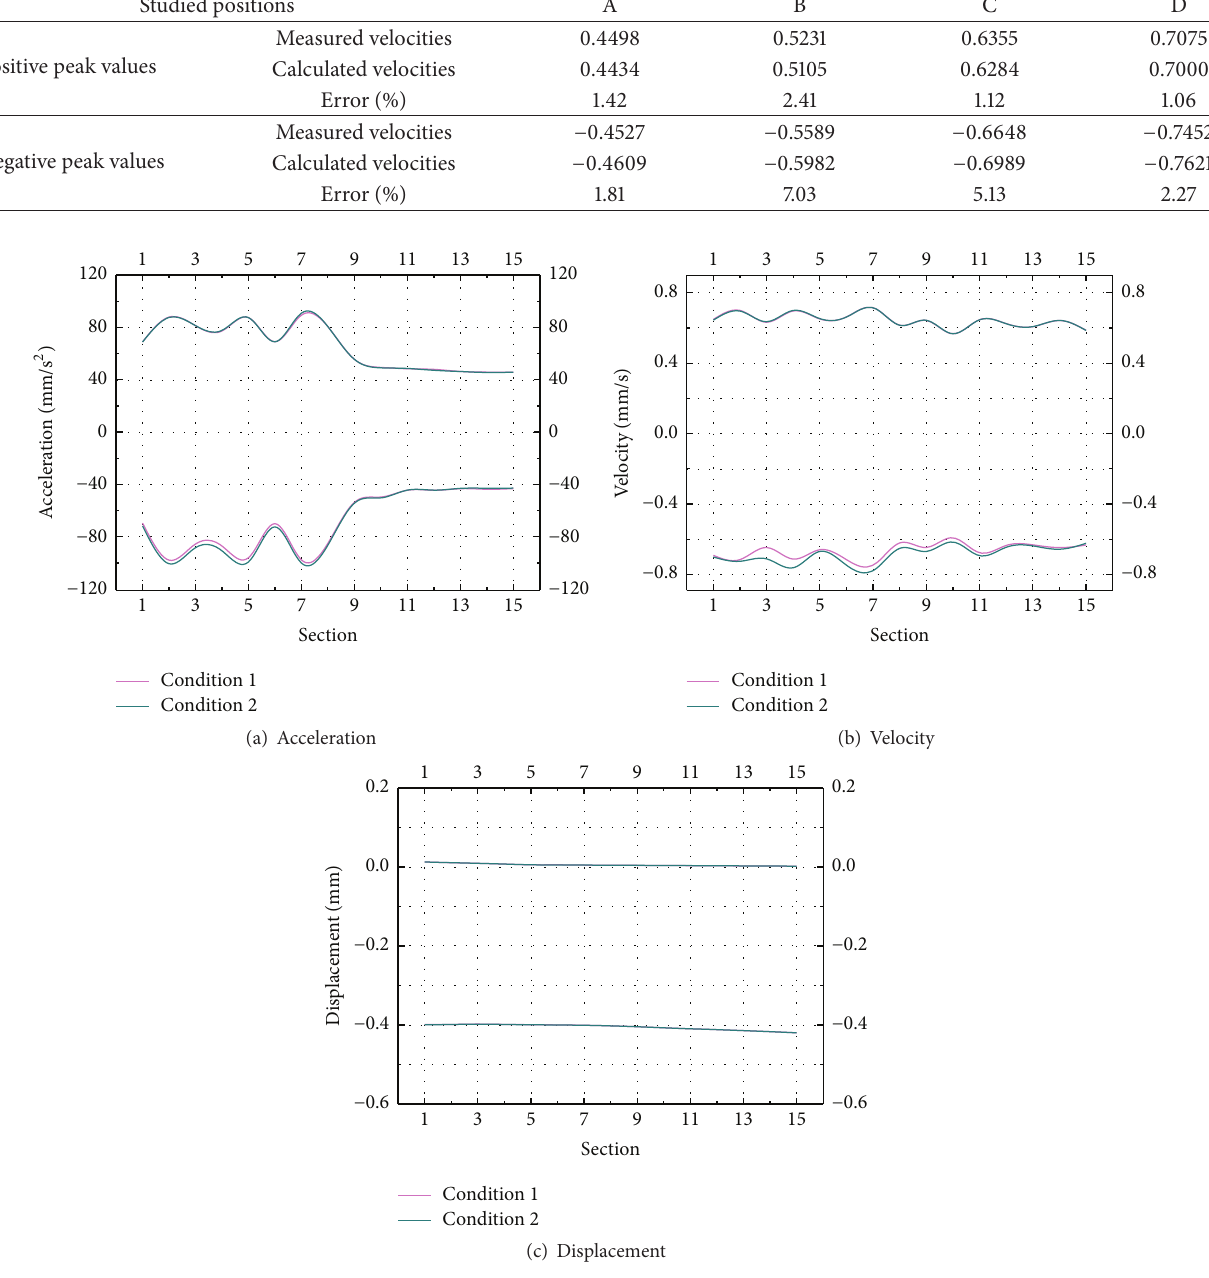
Figure 11: The maximum and minimum values of point D in two conditions: (a) acceleration, (b) velocity, and (c)